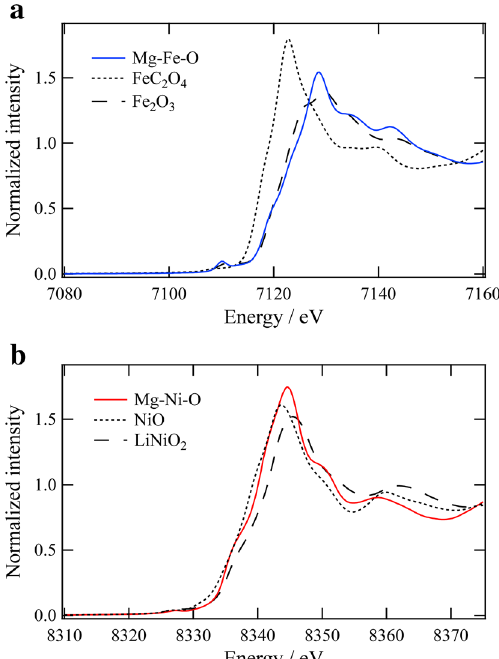
Figure 2. XANES spectra at ( a ) Fe K -edge of Mg–Fe–O and ( b ) Ni K -edge of Mg–Ni–O with reference materials.